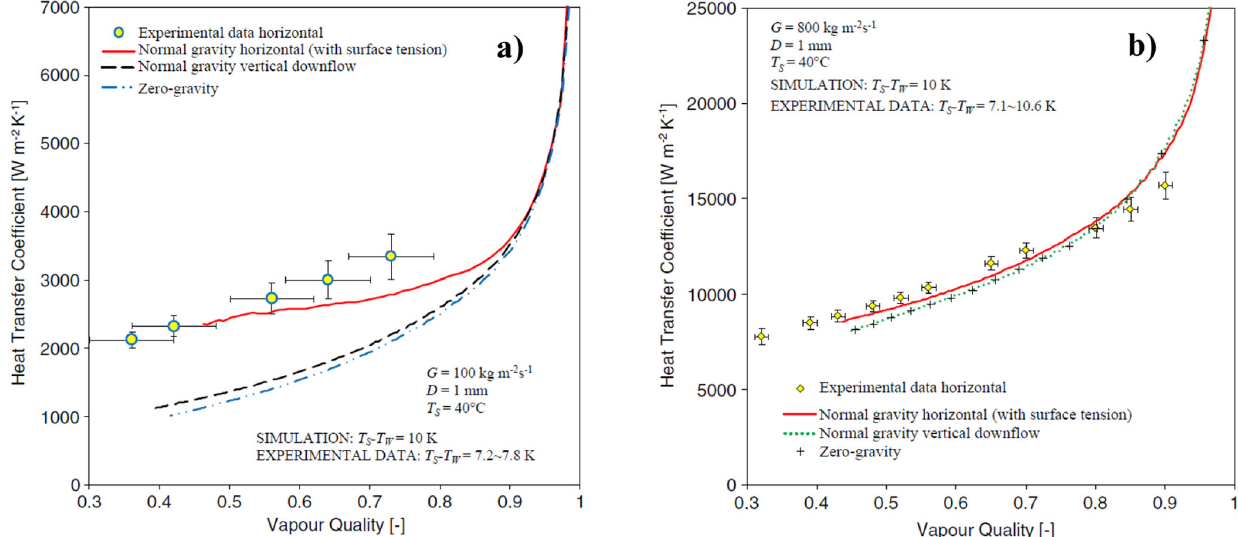
Fig. 4 In-tube condensation heat transfer coef fi cients under zero-gravity resulting from numerical simulations, compared to horizontal and vertical con fi gurations. Cross-sectional average heat transfer coef fi cients versus vapor quality at ( a ) G = 100 kg m − 2 s − 1 and ( b ) G = 800 kg m − 2 s − 1 during condensation inside a 1 mm inner diameter minichannel (Da Riva and Del Col 31 ). The error bars correspond to the combined (Type A and Type B) experimental